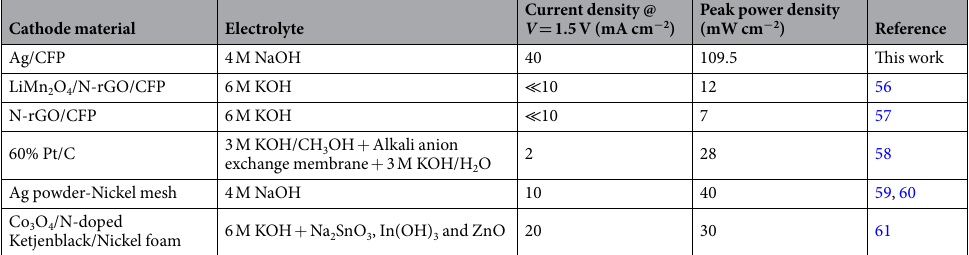
Table 3. A survey of the Al-air batteries in alkaline electrolytes and at atmospheric air without oxygen feed with key parameters extracted from the